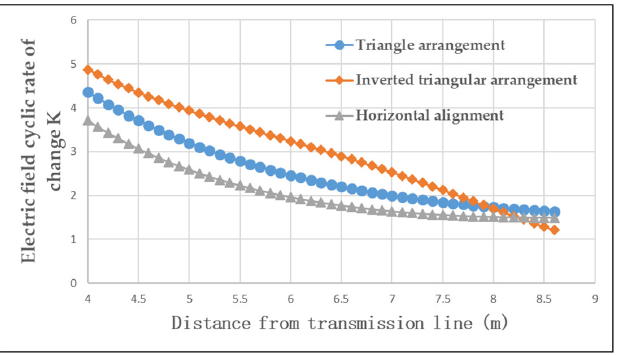
Figure 9. K value curve of the 45 degree flight path in different arrangement modes of 110 kV.